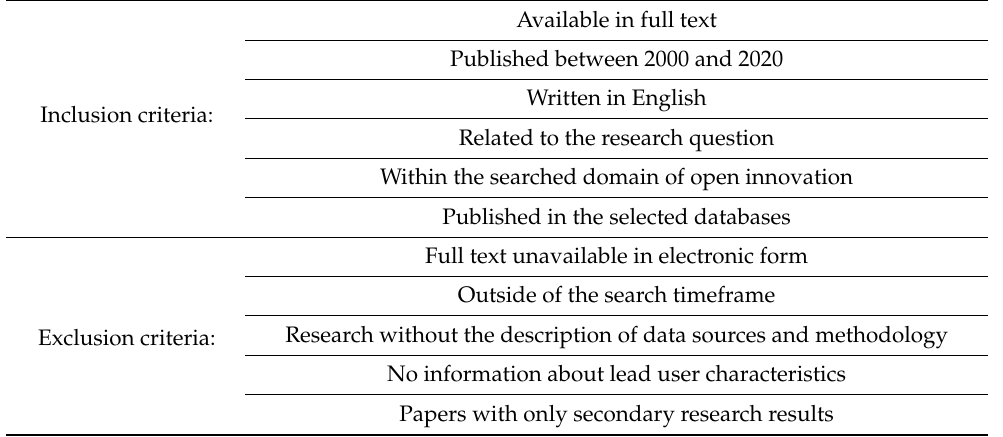
Table 1. Inclusion and exclusion